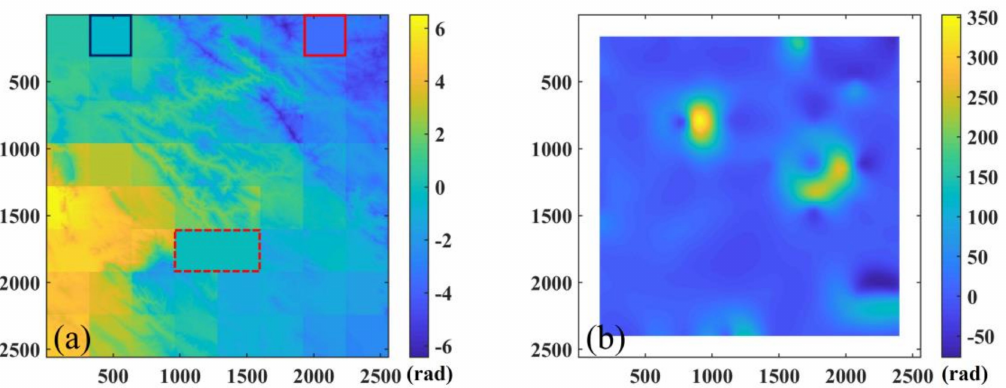
Figure 8. Resulting stratification delay maps based on the estimated power–law model parameters at each window and the interpolated parameter maps. ( a ) reconstructed atmospheric delay map base on power-law model with a single set of estimated parameters of each window; ( b ) reconstructed atmospheric delays base on power-law model with interpolated parameters maps. Dashed box denotes the masked zone. Solid boxes denote where power-law parameter estimation